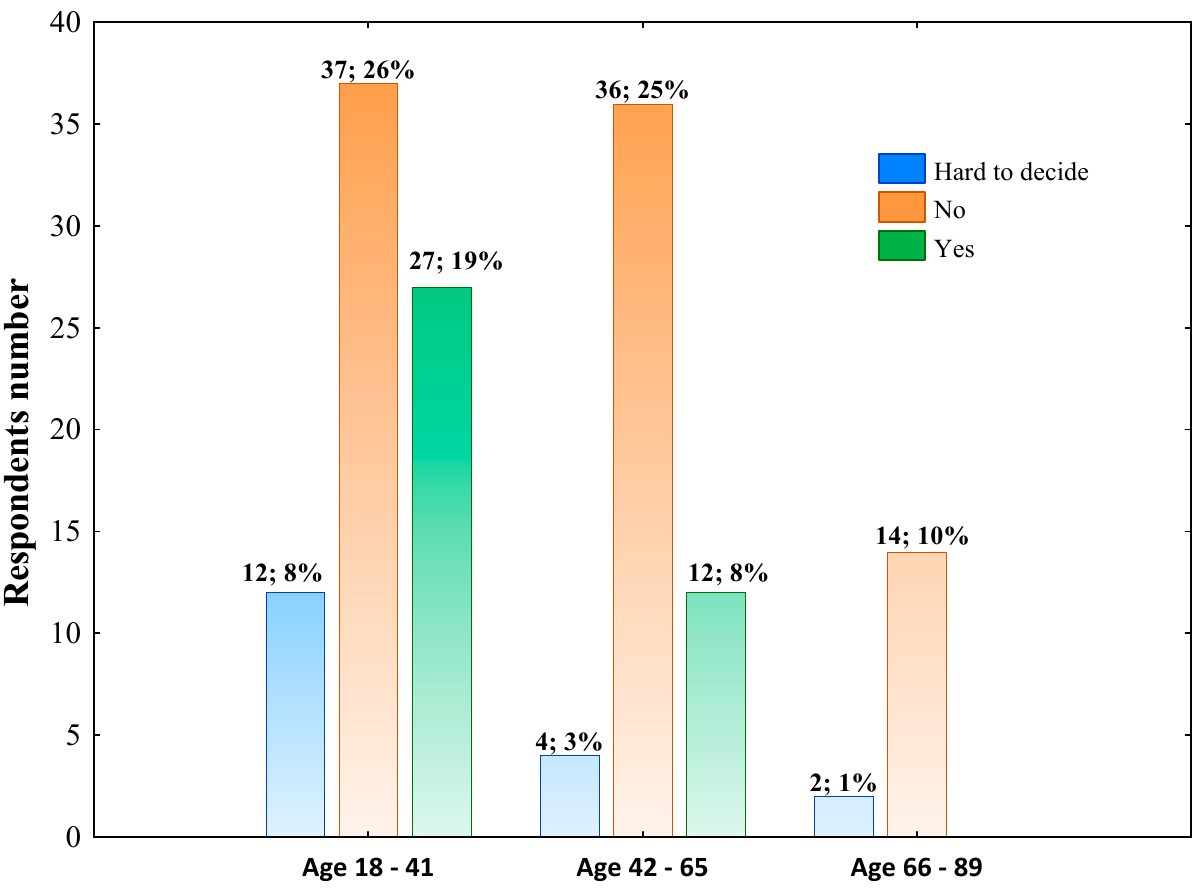
Figure 2. The effect of pandemic COVID-19 on changing dietary habits across age groups. The column description includes the respondents’ number aged in this range who chose such an answer, followed by the percentage of the total respondents. Data were analyzed using Pearson’s chi-squared test. Pearson’s χ 2 = 12.604; df = 4; p = 0.0134; n = 144.